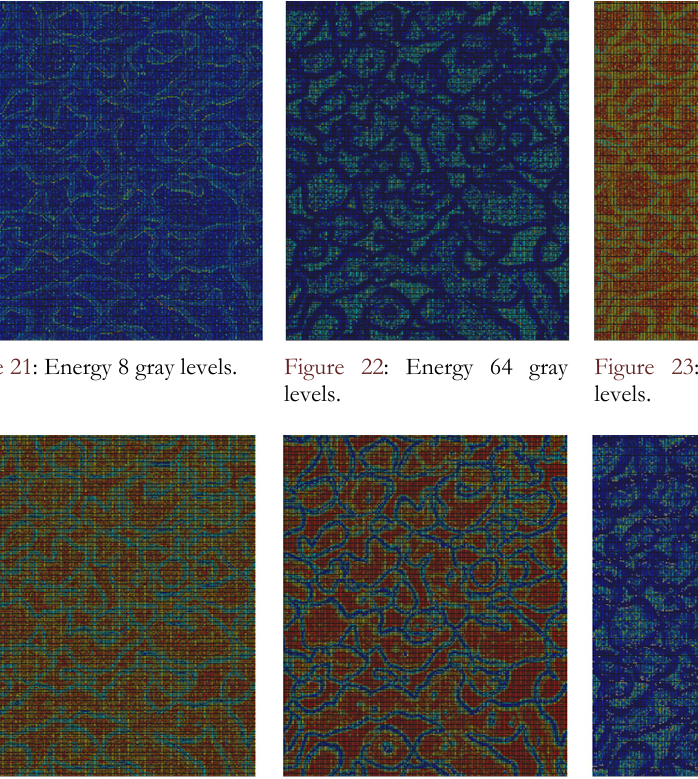
Figure 26: Mutual information 64 gray levels.